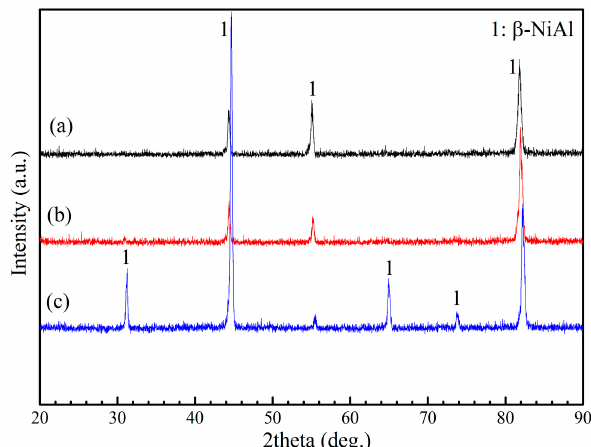
Figure 2. The X-ray diffraction (XRD) patterns of the as-deposited coatings: ( a ) NiAl–Hf, ( b ) NiAl–Zr, ( c ) NiAl–Hf–Zr.